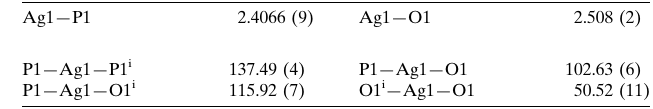
Selected geometric parameters (A˚ , (cid:1)